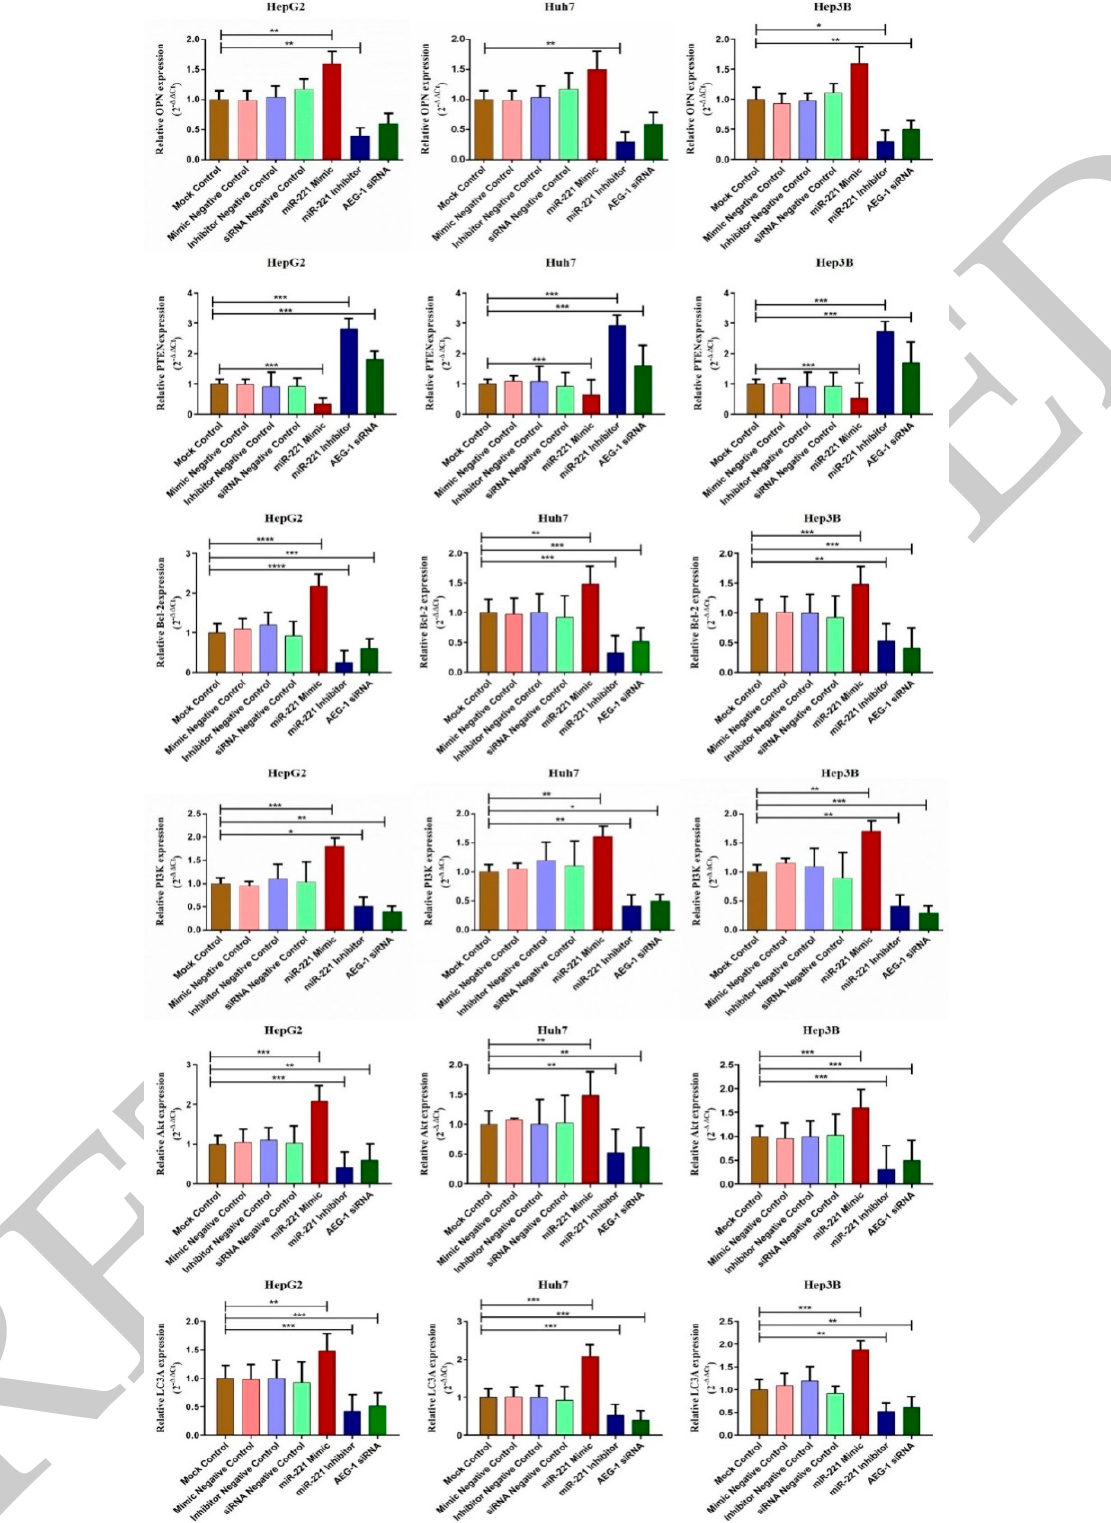
Figure 3. miR-221 / AEG-1 regulates apoptosis and autophagy regulatory mRNAs in HCC cell line. The e ff ect of miR-221 / AEG-1 on PI3K, Akt, PTEN, OPN, Bcl-2, and LC3A mRNAs expressions analyzed in mock control, miR-mimic negative control, miR-Inhibitor negative control, miR-221 mimic, miR-221 Inhibitor, siRNA-negative control, and AEG-1 siRNA transfected HepG2, Huh7, and Hep3B cells by qRT-PCR using GAPDH as an internal control. Error bars are presented as mean ± s.d. and * p < 0.05, ** p < 0.01, *** p < 0.001, **** p < 0.0001 compared with NC control